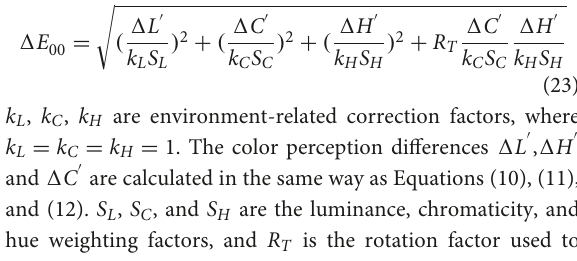
calculated as the average difference in the values of the spectral curves at each wavelength, and the calculation formula is the same as the Equation (18) in 3.2.4, the value range is 0–1, the smaller the value indicates the smaller the error; (2) The spectral goodness-of-fit coefficient measures the similarity of the shape of the spectral curves of the two samples by the angular cosine difference of their spectral curves, and the result ranges from 0 to 1. The closer to 1 means that the estimated spectral curve fits the actual spectral curve better, and the calculation formula is as in Equation (21).